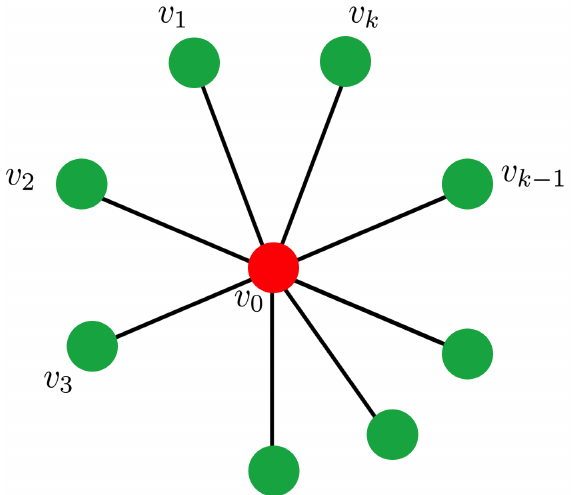
Figure 4. A sketch of a star graph with a junction node υ 0 and k